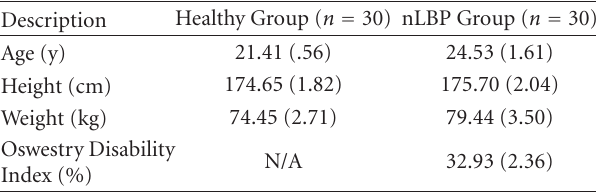
Table 1: Descriptive statistics. Values represent means (SD).